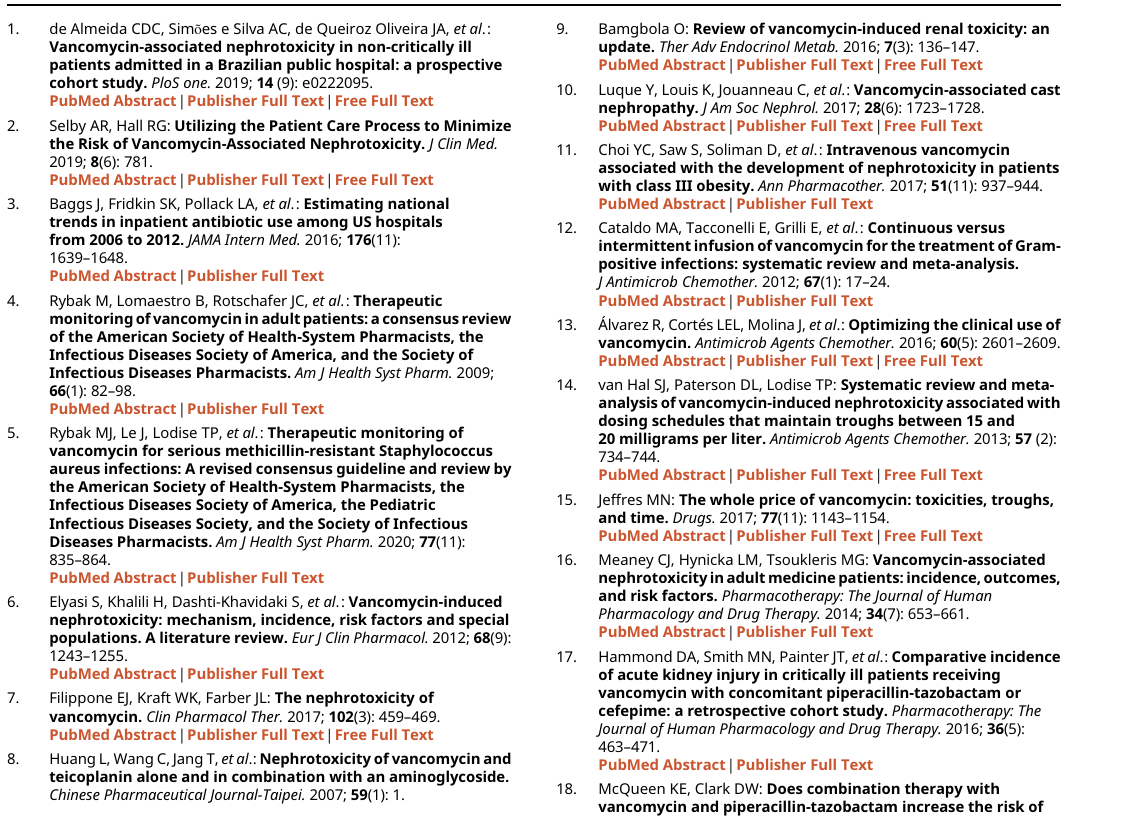
Figshare:Underlying datafor ‘ Impactofascorbicacidinreducingtheincidenceofvancomycinassociatednephrotoxicity in critically ill patients: A preliminary randomized controlled trial ’ , https://doi.org/10.6084/m9.figshare.15710004.v1. 28 This project contains the following underlying data: